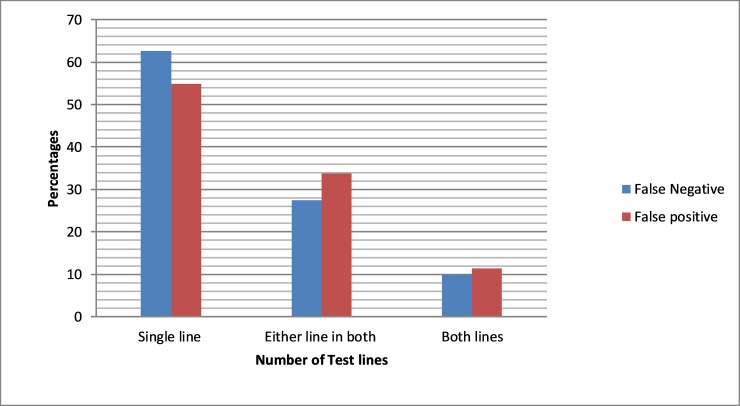
Characterization of interpretation errors of RDT by test line results.